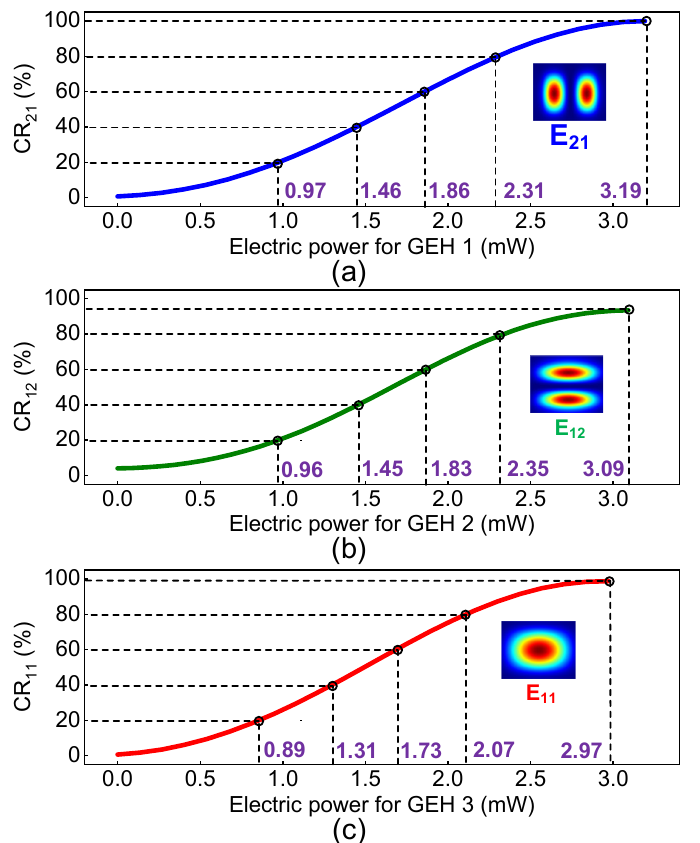
Figure 8. The CRs of ( a ) the E 21, ( b ) the E 12 and ( c ) the E 11 modes with different electric power applied to the GEHs.